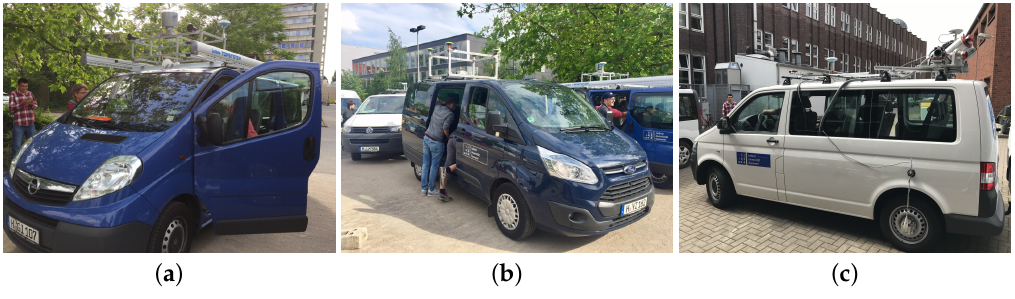
Figure 2. The participating vans with mounted sensor platforms during the mapathon: ( a ) GIH van, ( b ) IfE van and ( c ) IKG van.